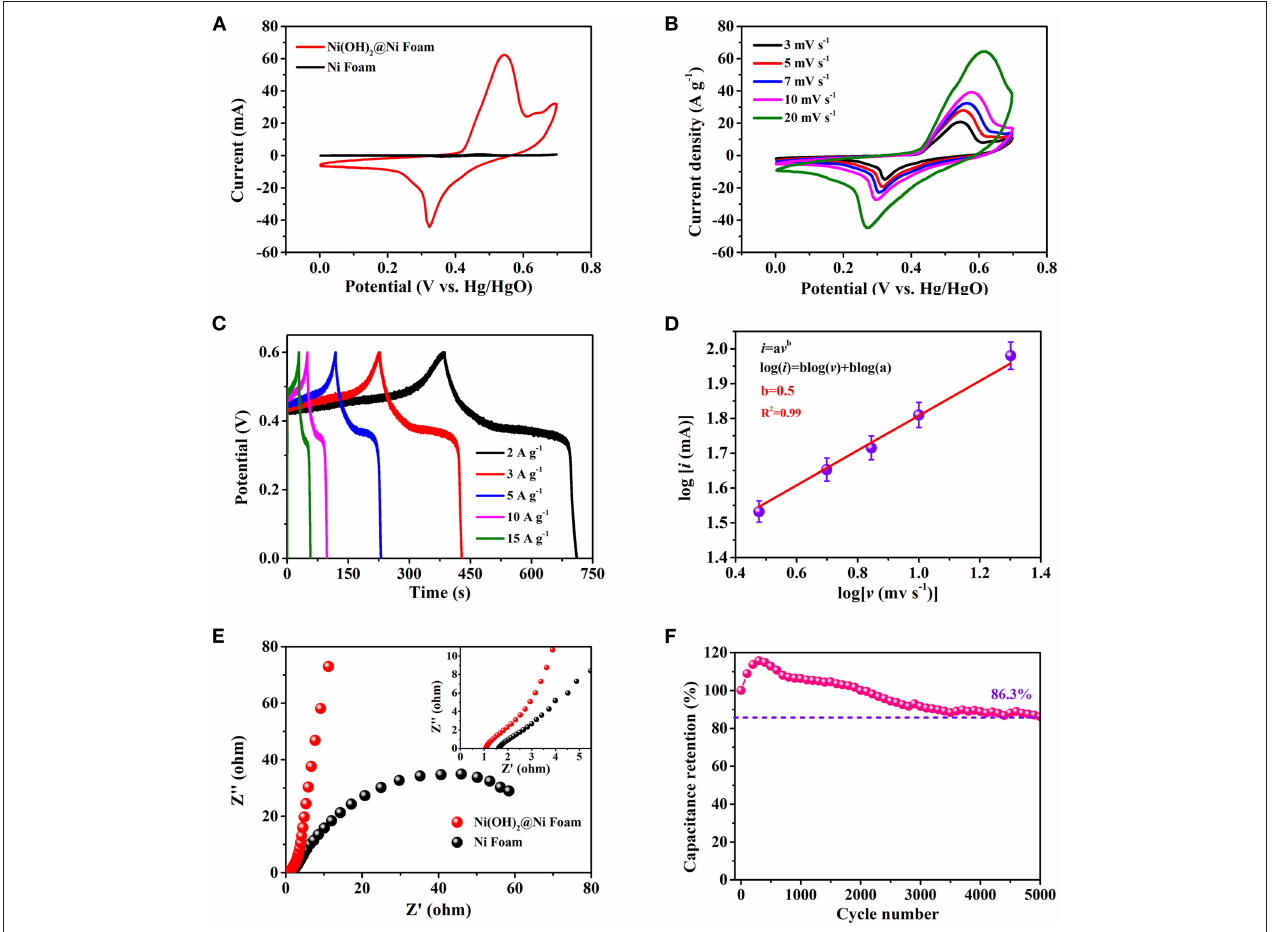
FIGURE 3 | Three-electrodes electrochemical measurements of β -Ni(OH) 2 electrodes in 1M of KOH aqueous solution. (A) CV curves of the electrodes with scan rates from 3 to 20mV s − 1 . (B) Specific capacitance and capacitance retention at different current densities. (C) GCD curves at various current densities. (D) Dependence of peak current and sweep speed after taking the logarithm. (E) Impedance Nyquist plots of the three-electrodes. (F) The cyclability of the electrode, the capacitance retention remains 86.3% after 5,000